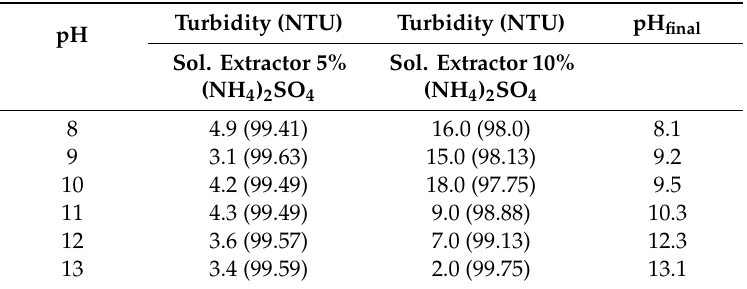
Table 7. Determining the optimal pH and final turbidity (% removal) obtained from the jar test in urban wastewater at an optimum flocculant dose of 0.38 g L − 1